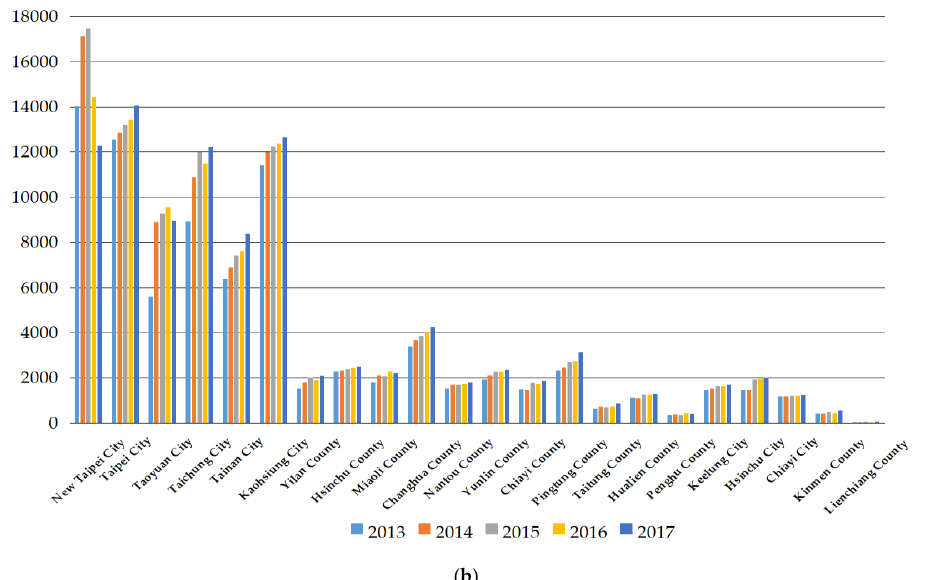
Figure 1. ( a ) Carrying capacity of physicians for administrative regions in Taiwan; ( b ) Carrying capacity of nurses for administrative regions in Taiwan.